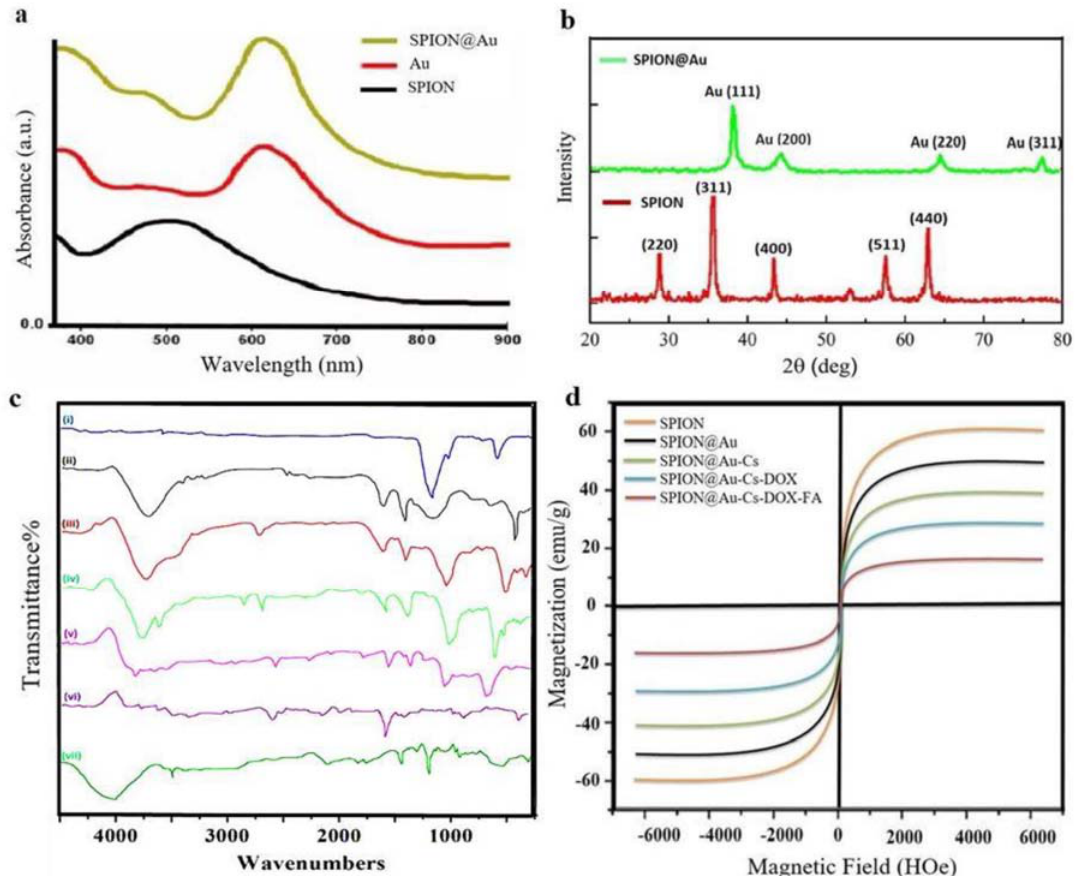
Figure 2. UV visible ( a ) and XRD ( b ) characterization of the prepared SPION@Au core-shell NPs. FT-IR spectra ( c ) of the prepared SPION@Au-CS-doxorubicin (DOX)-FA NPs. Au (i), SPION (ii), SPION@Au-Cs (iii) SPION@Au-CS-DOX-FA (iv), and DOX (v), FA (vi) Cs (vii) magnetic hysteresis curve ( d ) of the prepared SPION@Au-CS-DOX-FA